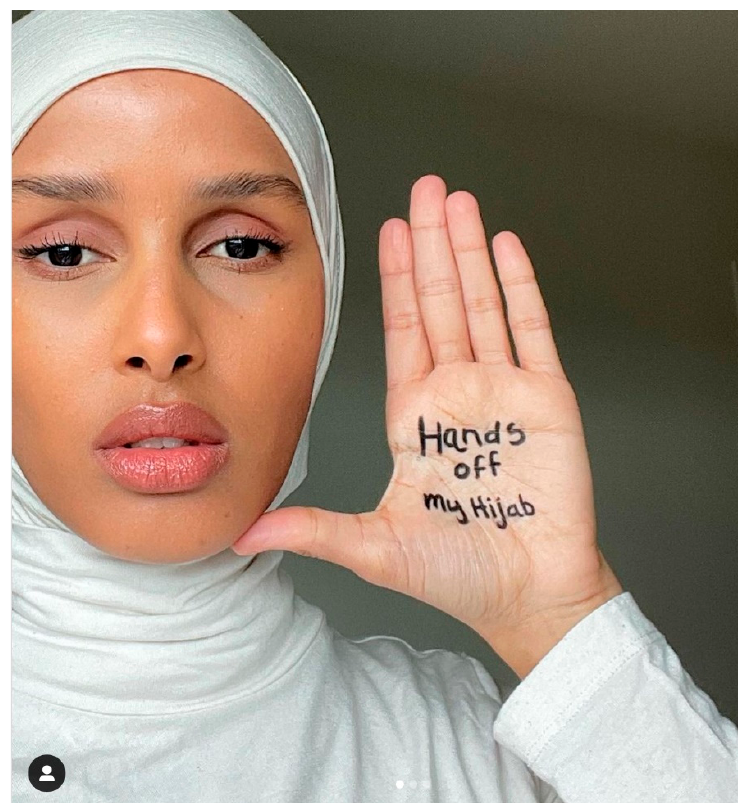
Figure 2. Posting of rawdis on Instagram cited after Al Jazeera (2021).